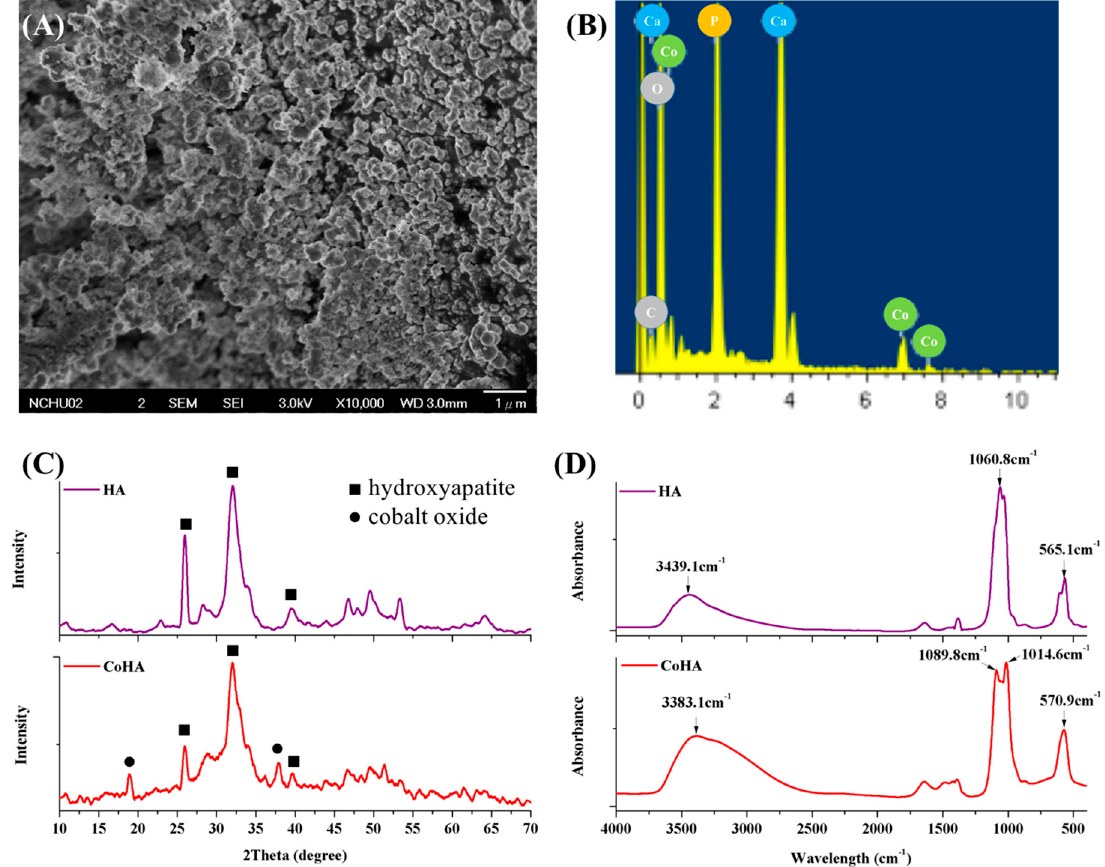
Figure 1. ( A ) Field emission scanning electron microscopy (FESEM) image of cobalt-substituted hydroxyapatite (CoHA) powder, ( B ) surface element analysis of CoHA by energy dispersive X-ray spectroscopy (EDS), ( C ) X-Ray diffraction (XRD) patterns of hydroxyapatite (HA) and CoHA, ( D ) IR spectra of HA and CoHA by FTIR.